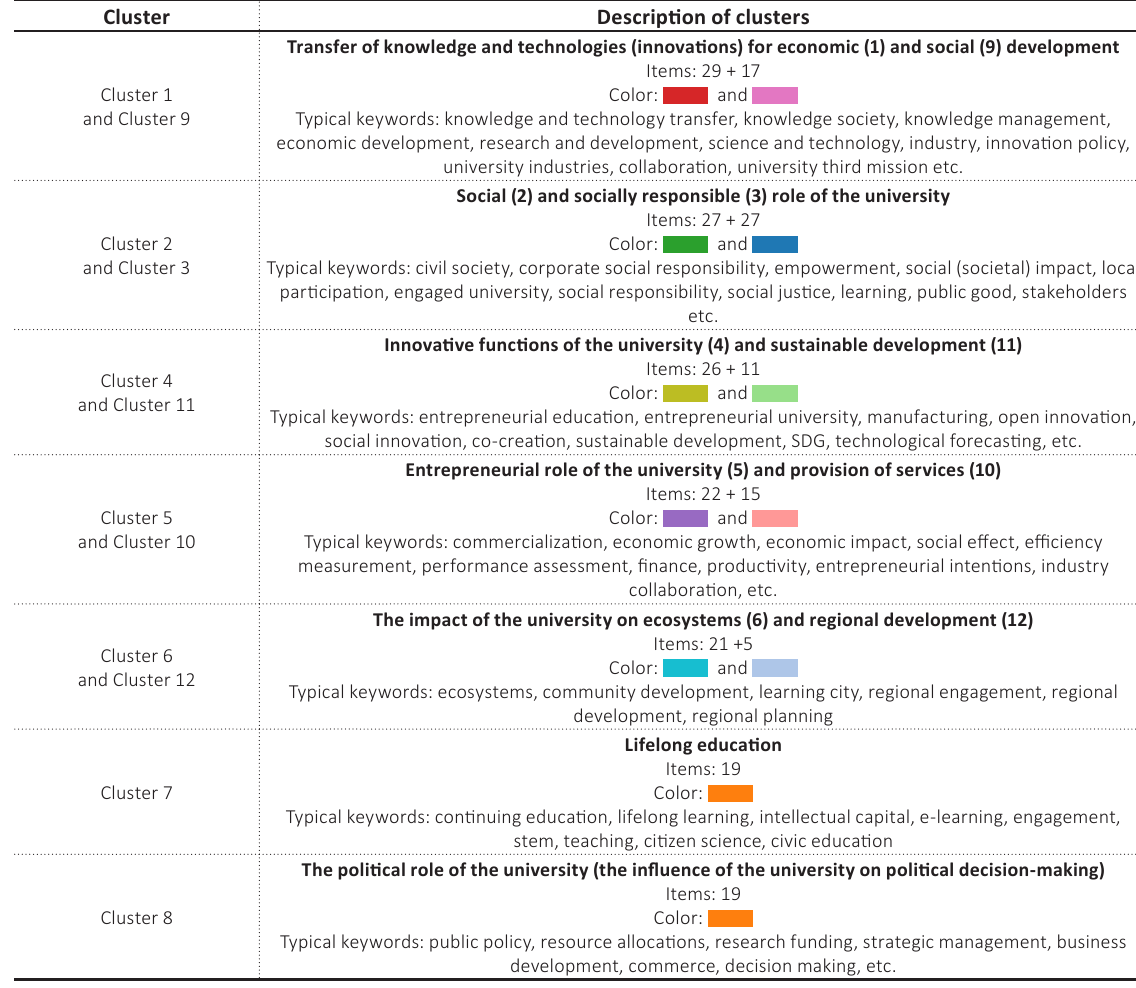
Table 2. Description of clusters of bibliometric analysis on the third mission of the university Cluster Description of clusters Cluster 1 and Cluster 9